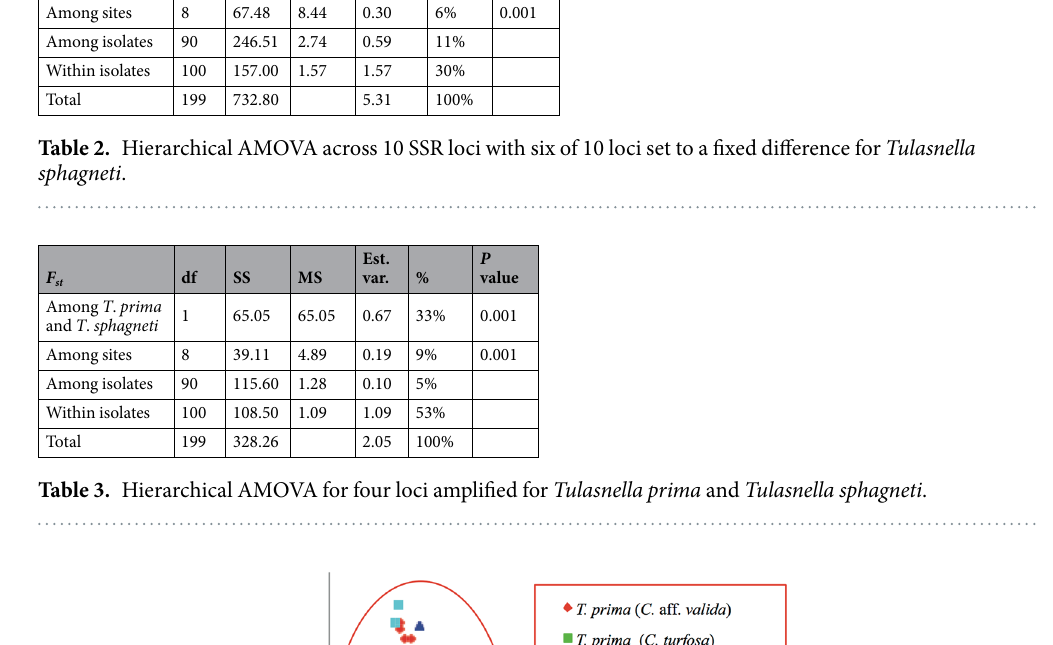
df SS MS Est. var. % P value